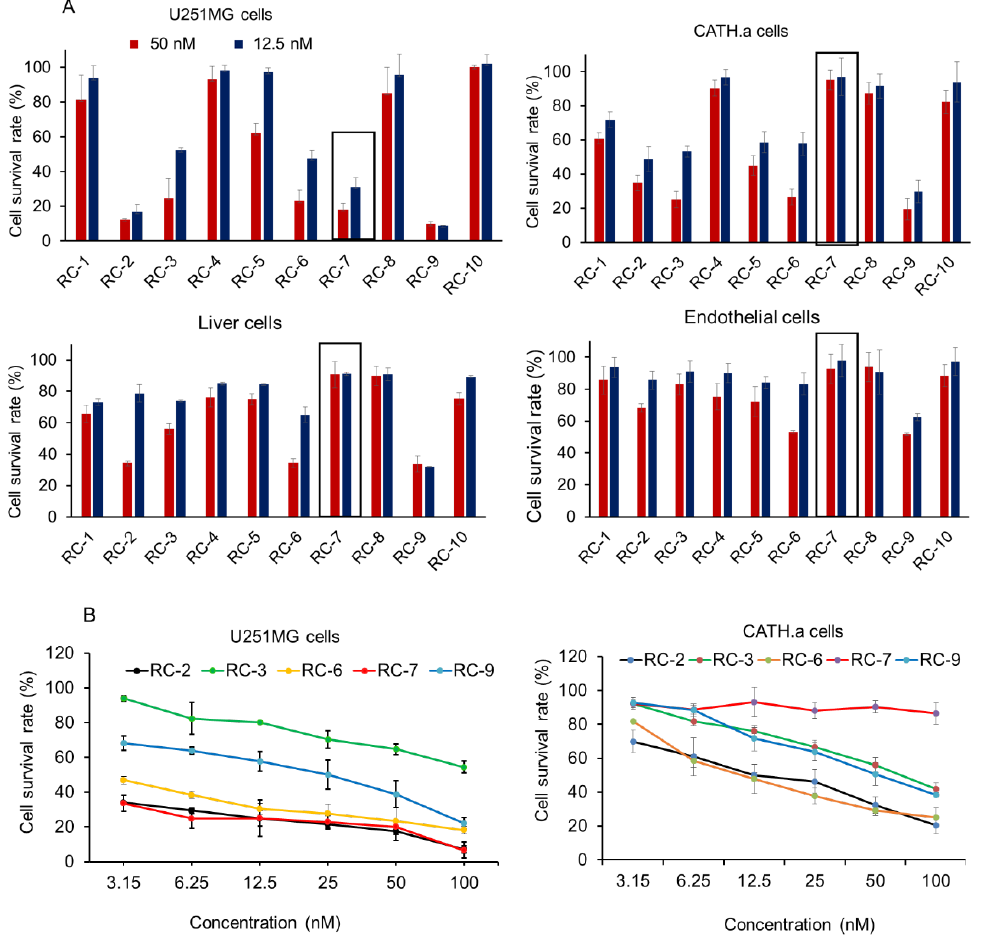
Figure 2. Cell viability and concentration-effect relationship of complexes RCs with different types of cells at 50 nM and 12.5 nM. ( A ) Cell viability of U251MG human glioma cells, CATH.a neuronal cells, liver cells, and human endothelial cells after RC-7 addition. The values represent the mean ± SEM of the cell survival rate. The survival rate (%) was calculated as OD (sample–blank) / (control–blank) × 100%. ( B ) Dose-response curves of U251 and neuronal cell proliferation after RC-2, RC-3, RC-6, RC-7, and RC-9 were respectively added into the cell media at the concentration of 3.15~100 nM.